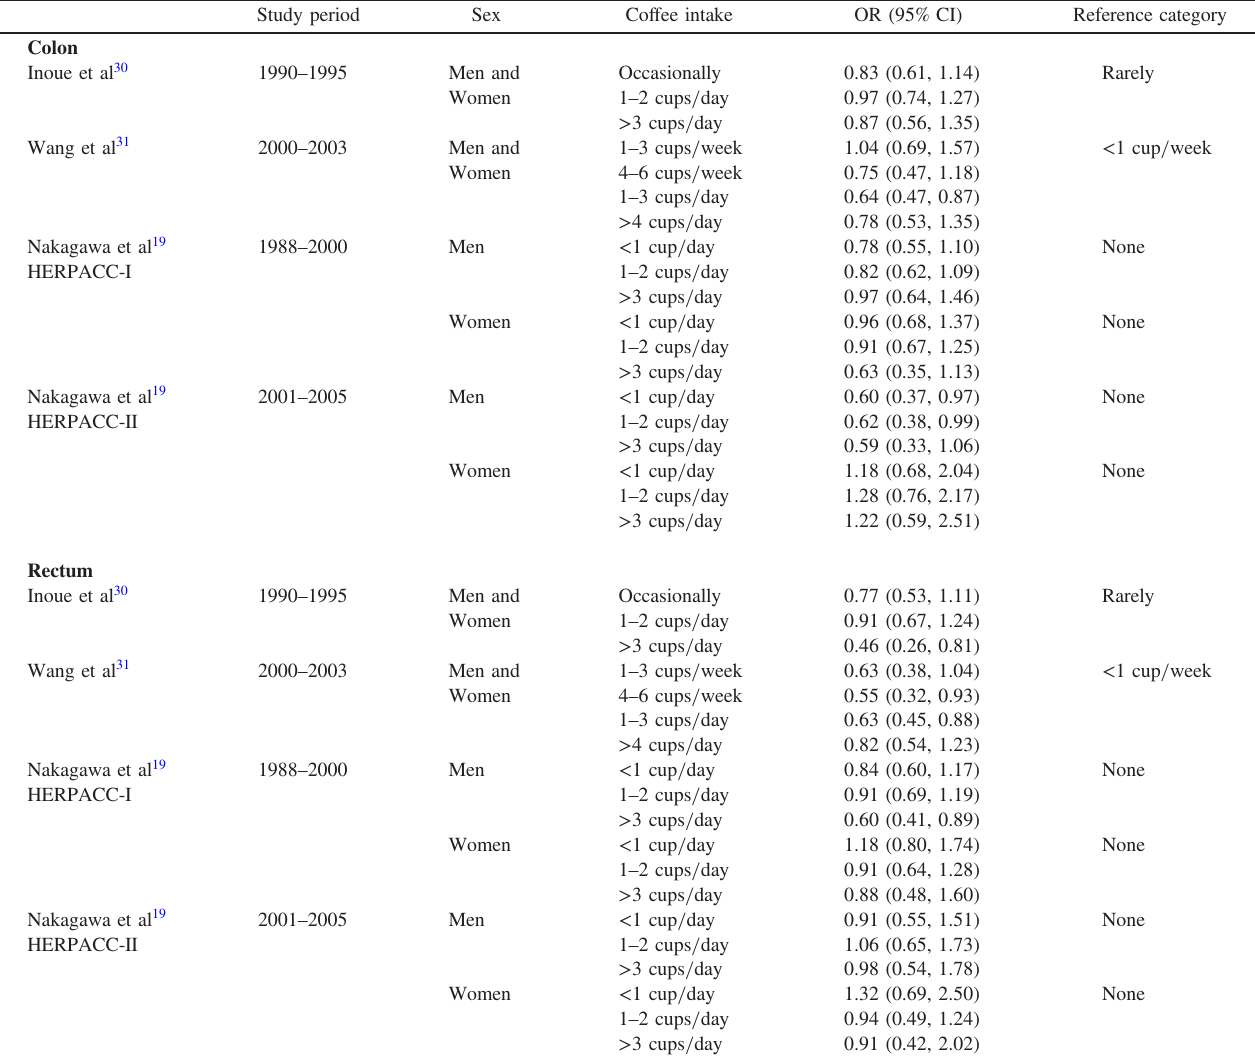
Table 2. Characteristics of case-control studies evaluating co ff ee consumption and colorectal cancer risk included in a meta-analysis Study